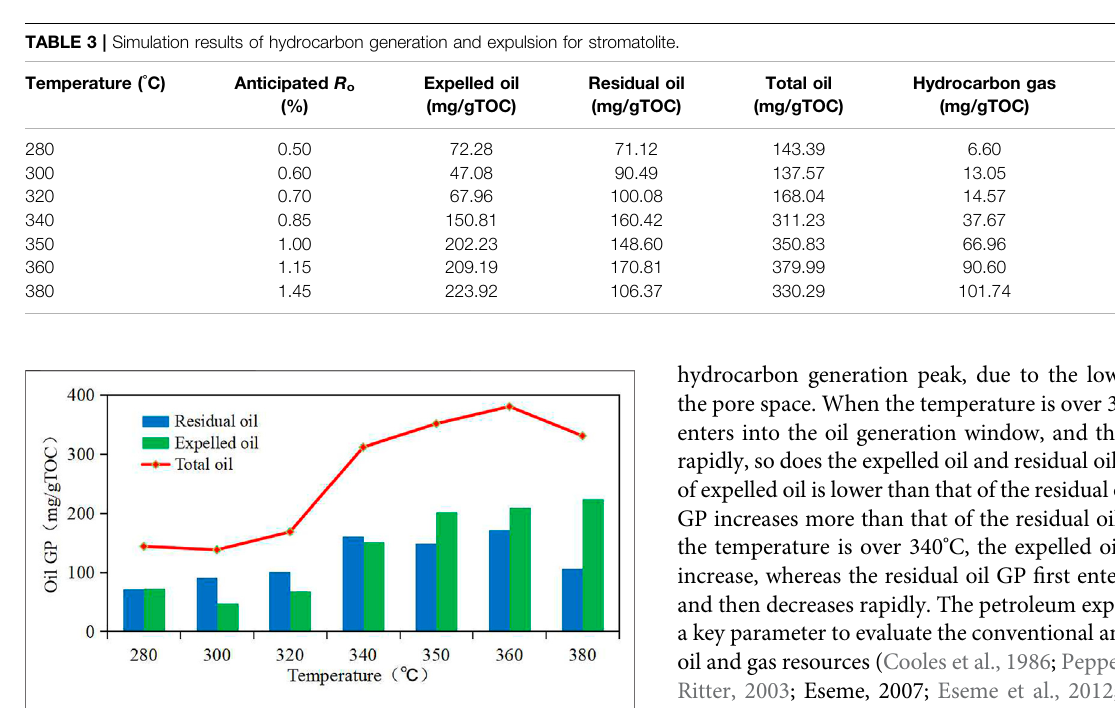
FIGURE 4 | Oil generation potential of hydrocarbon generation and expulsion from stromatolite.